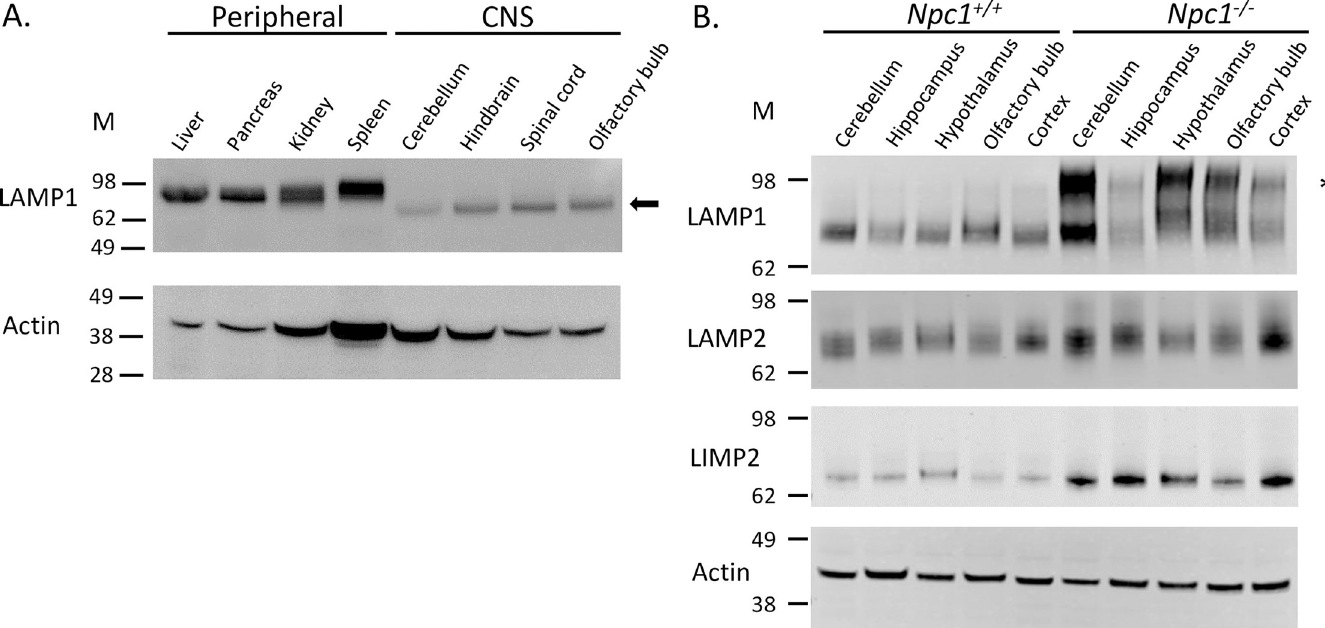
Fig 1. Lysosomal membrane proteins in NPC1 tissues. A. Western blot of 7-week Npc1 +/+ peripheral tissues (liver, pancreas, kidney, spleen) and CNS tissues (cerebellum, hindbrain, spinal cord, olfactory bulb) for LAMP1 and actin (loading control). B. Western blot of CNS tissues from 9-week Npc1 +/+ and Npc1 −/− mice for LAMP1, LAMP2, and LIMP2. β -III tubulin was used as a loading control. The asterisk ( � ) marks the larger size of LAMP1 that is referenced as hyperglycosylated LAMP1 in the text. Arrow indicates LAMP1 size of ~75 kDa in CNS tissue (see S1 Fig for size estimate).